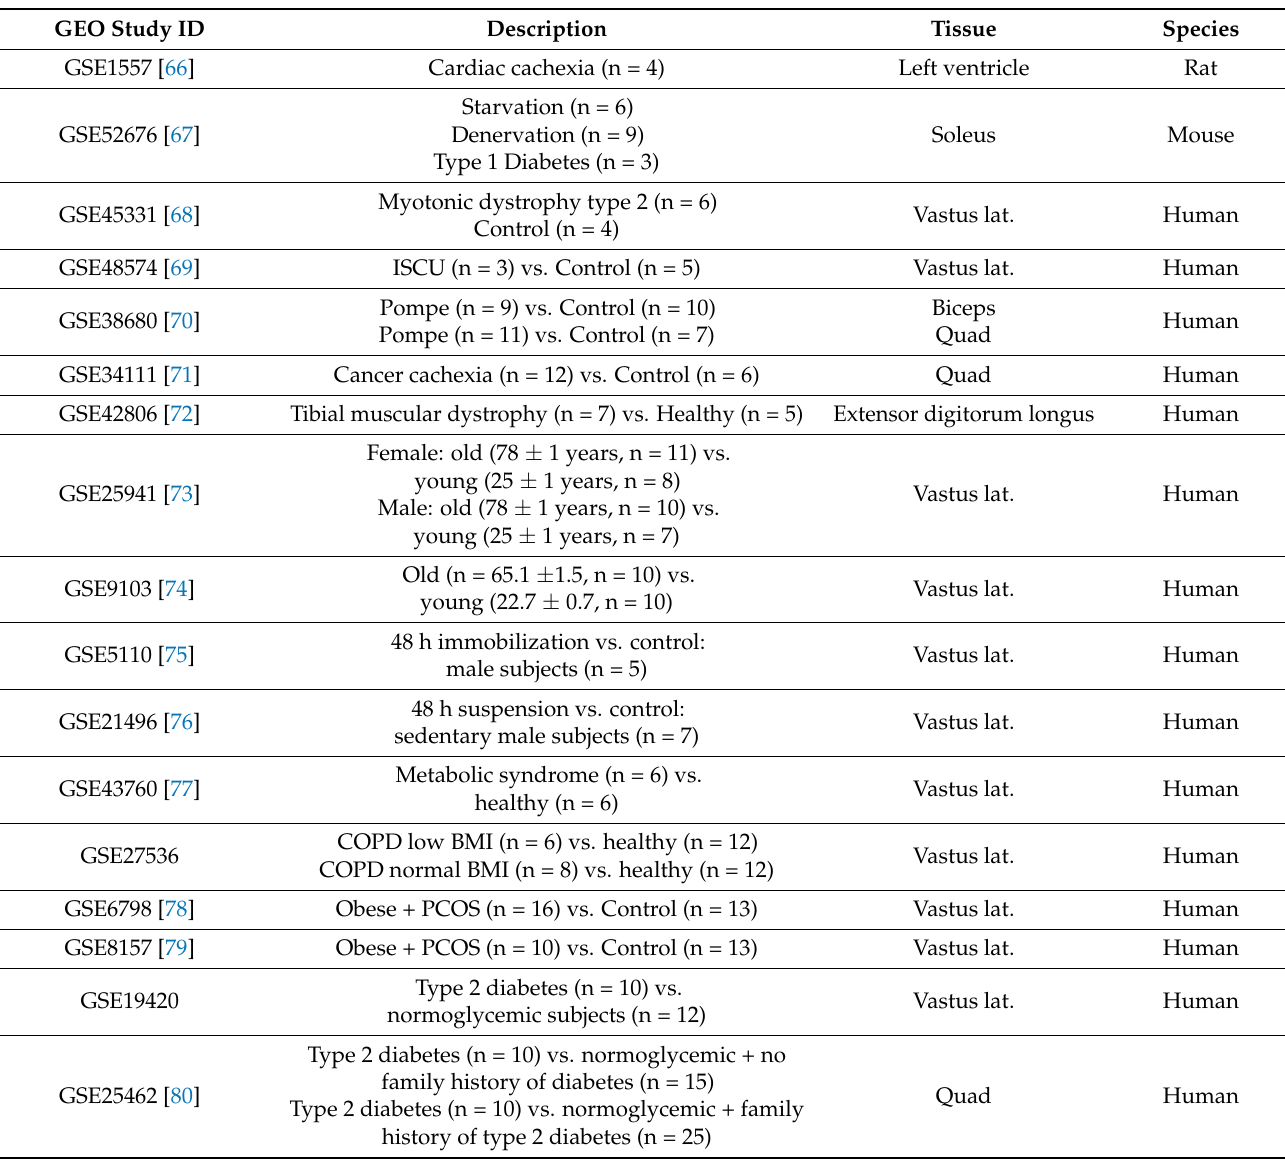
Table 2. Gene Expression Omnibus (GEO) myopathy studies included in